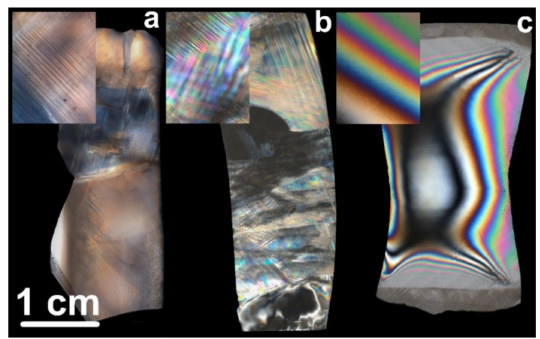
Figure 1. Polarized light microstructure images of as-grown crystals: ( a ) 9ScSZ, ( b ) 9Sc0.5YbSZ, and ( c )